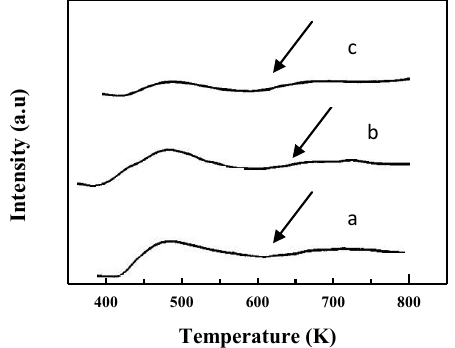
Figure 3. NH 3 -TPD profiles of ( a ) SiO 2 (pretreated at 600 °C for 2 h); ( b ) 2.9 wt% TiO 2 /SiO 2 -500; ( c ) 7.1 wt% Cr 2 O 3 -6.3 wt% NiO/SiO 2 -500; and (d) 1.4 wt% TiO 2 -6.1 wt% Cr 2 O 3 /SiO 2 -500.